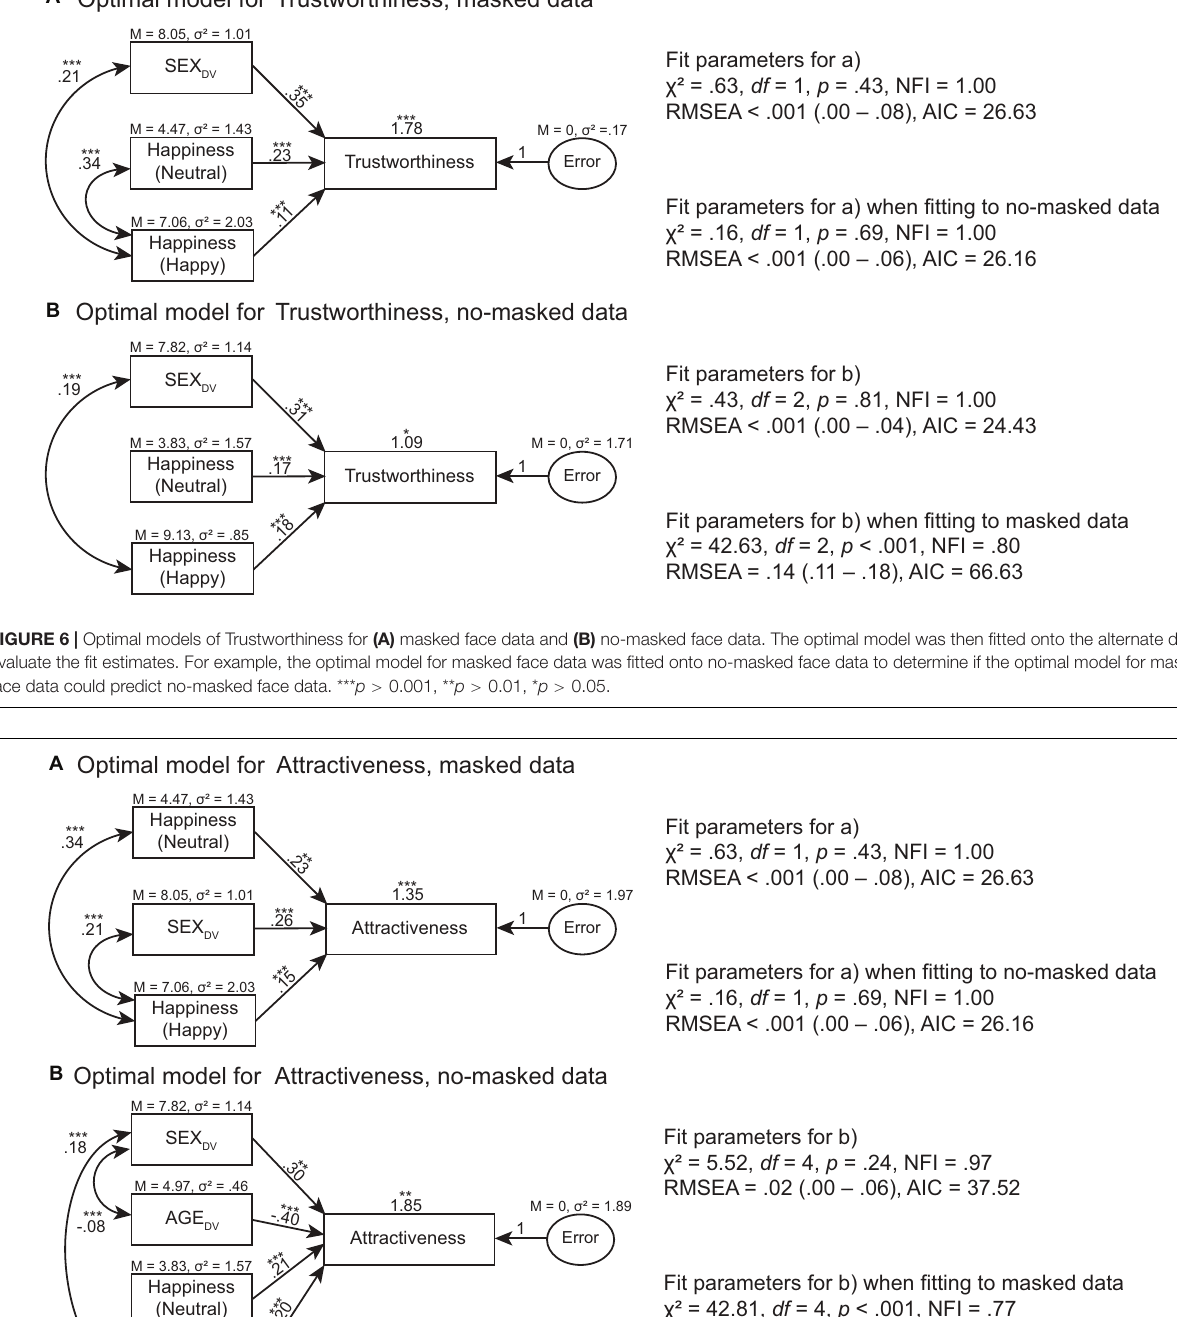
became severely impaired. However, we disagree with such conclusions. While face masks impede emotional expressions, it does not always impact social interactions